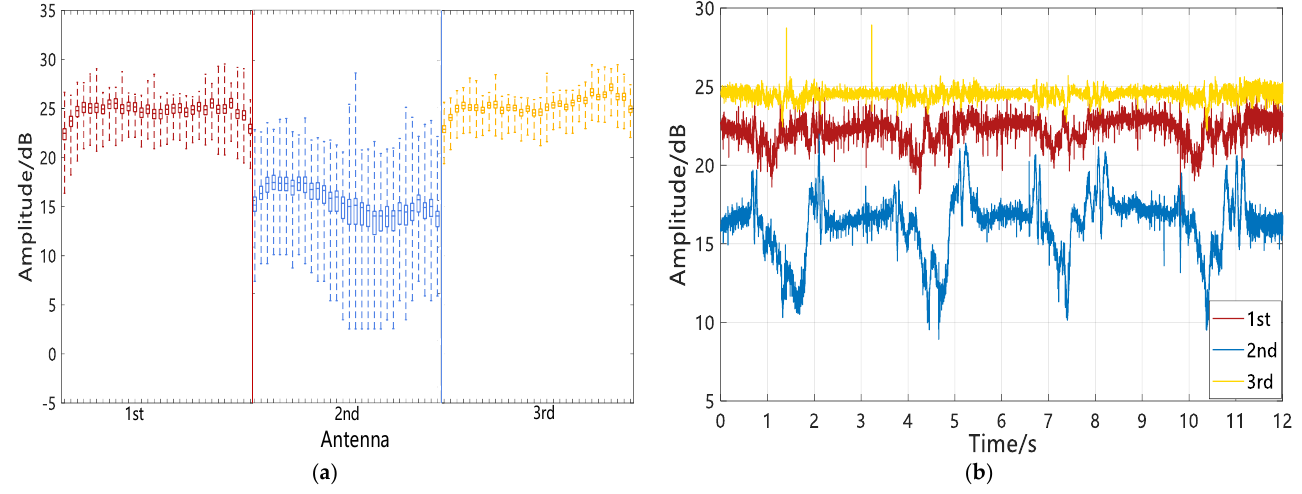
Figure 4. Antenna selection: ( a ) Comparison of the three antennas. ( b ) Subcarrier number one on three antennas.